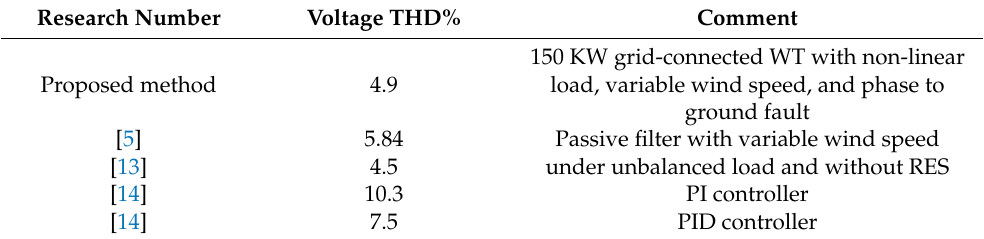
Table 3. Results compression for voltage THD with other papers.